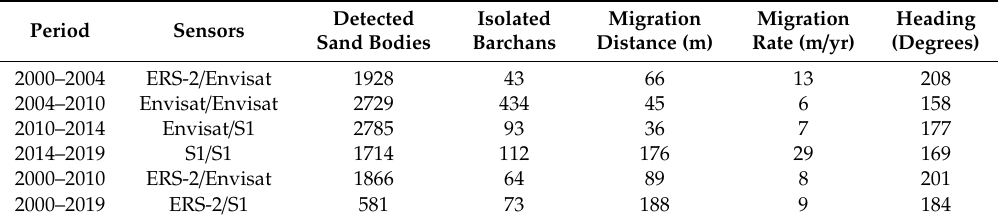
Table 7. Average filtered results based on dune area consistency criteria, measured over the South Rayan dune